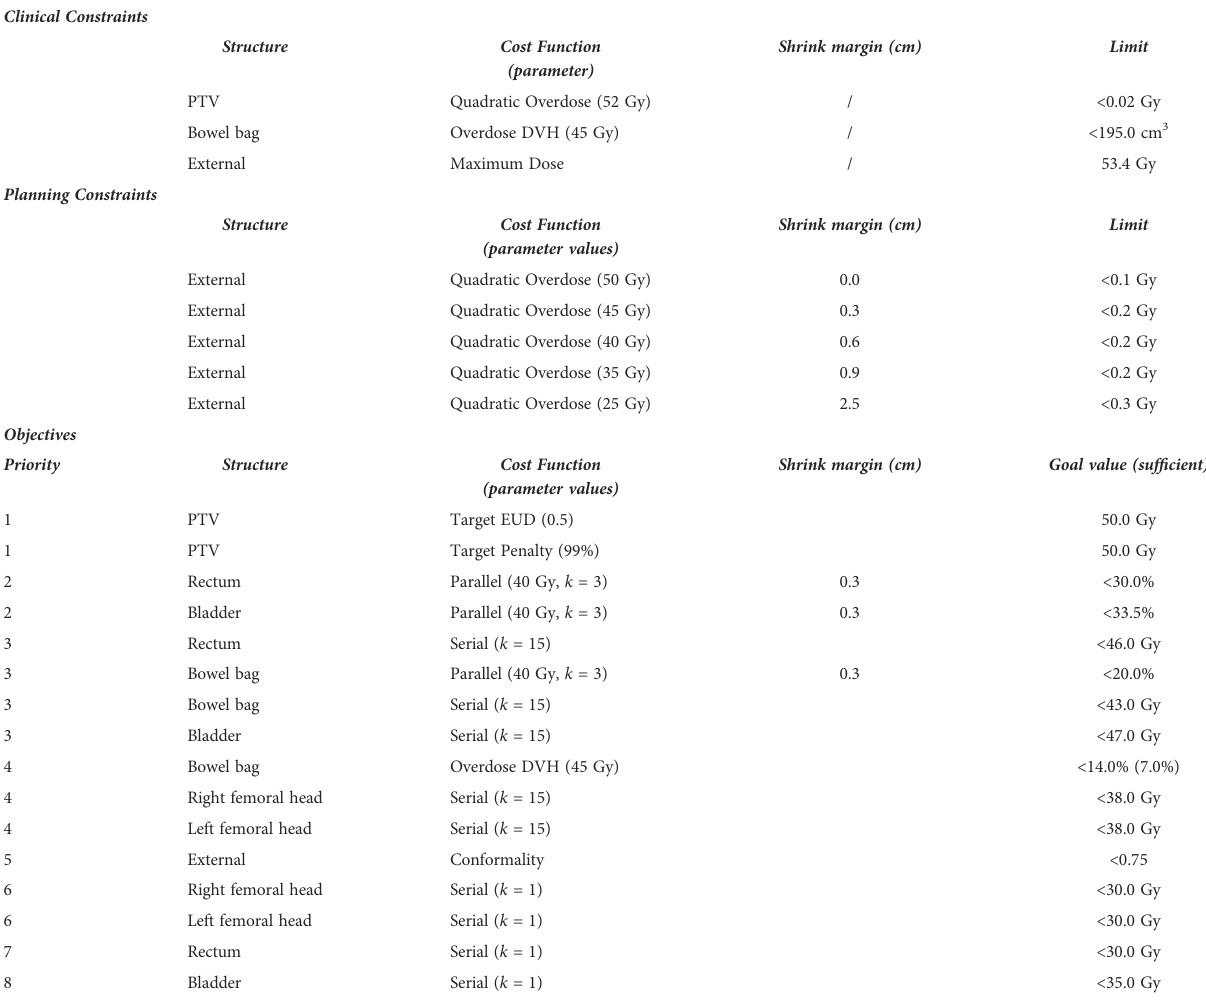
TABLE 1 mCycle wish-list for auto-planning of cervical cancer (50 Gy in 25 fractions). Clinical